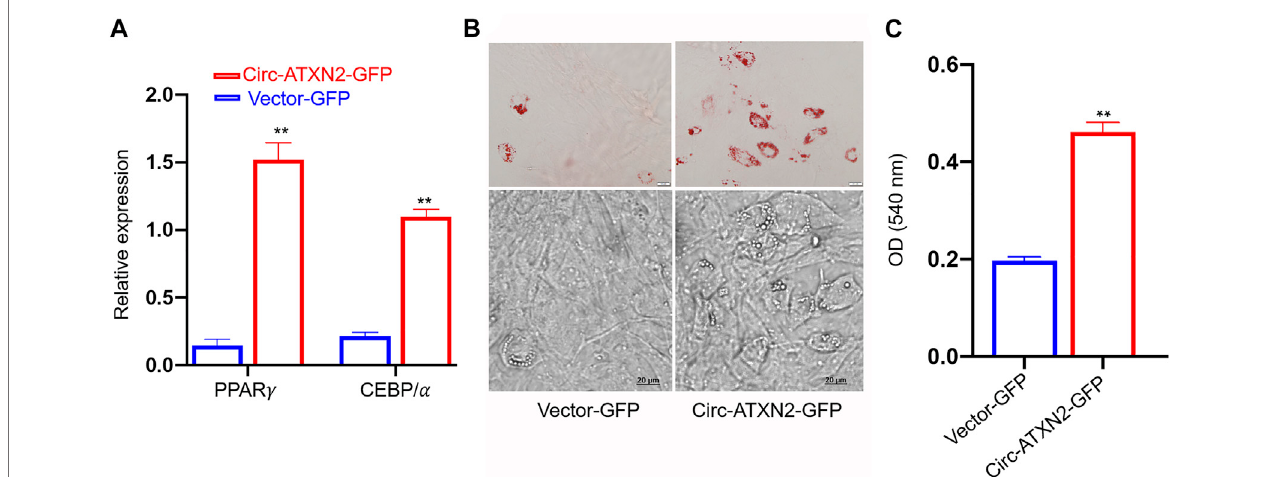
FIGURE 7 | Overexpression of circ-ATXN2 promoted adipogenic differentiation in rat adipose-derived stromal cells (ASCs). (A) The relative mRNA level of adipocyte speci fi c genes including PPAR c and CEBP/ α were measured at 48 hours of adipogenic differentiation. Results were presented as mean ± SEM, by two-way ANOVA,n (cid:1) 3;** p < 0.01, vs vector-GFPcells. (B) Representative microscopeimagesofdifferentiated adipocytesinvector-GFPand circ-ATXN2-GFPcellsatday 14of adipogenic differentiation. (C) Quanti fi cation of Oil Red O staining results by measuring the corresponding absorbance dye at 540 nm. Results were presented as means ± SEM, n (cid:1) 3; ** p < 0.01, by Student t test, vs vector-GFP